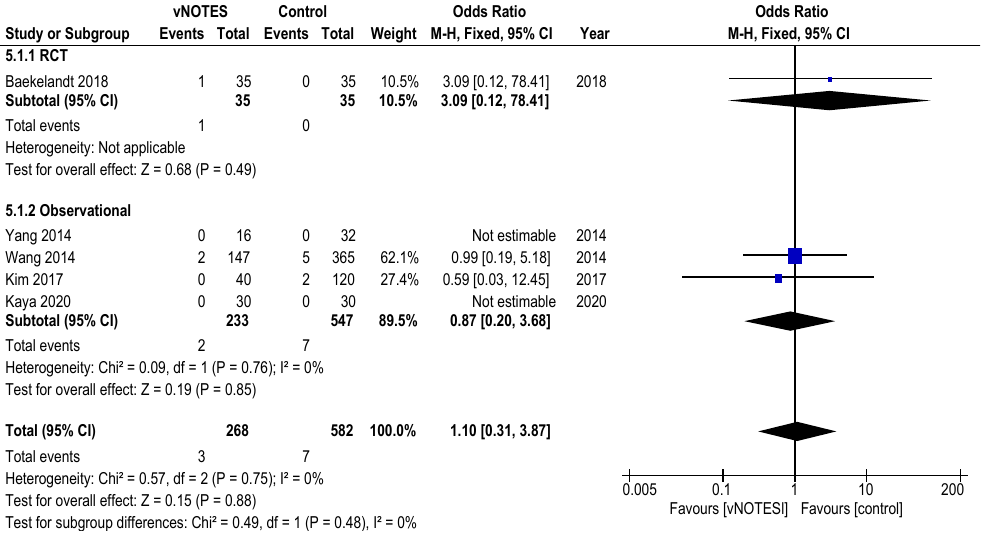
Figure 3. Forest plot of comparison vNOTES versus control, outcome: intraoperative complications.